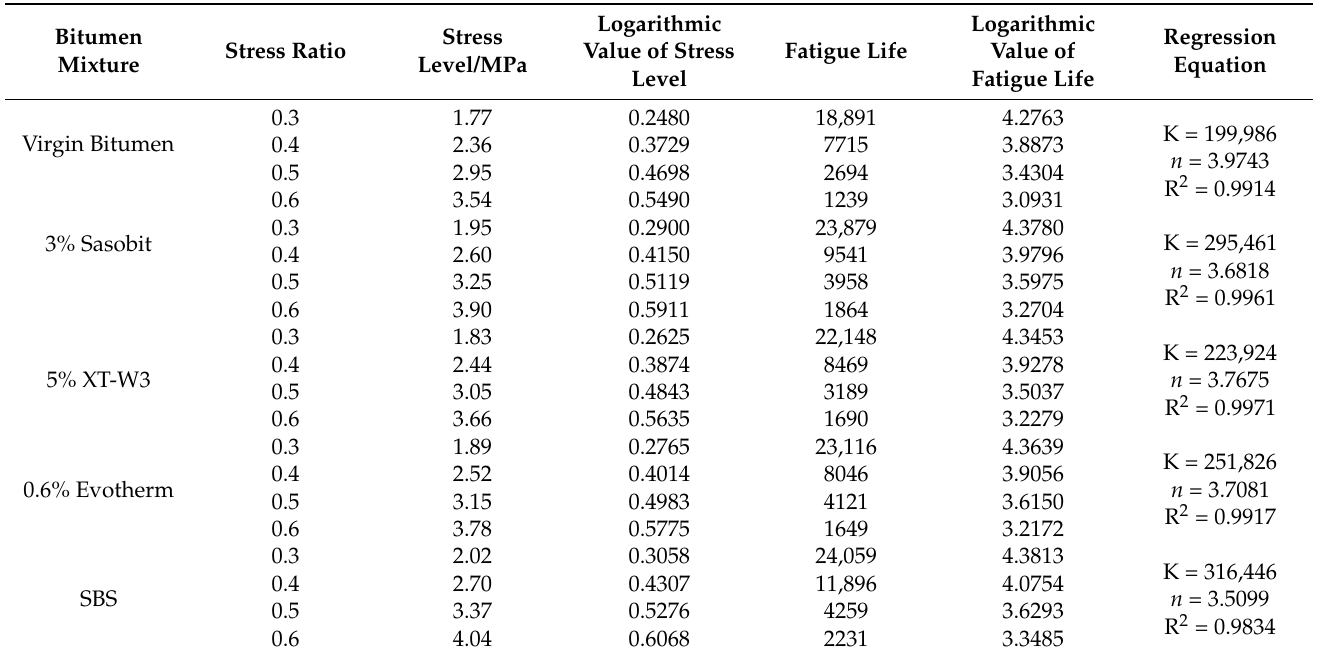
Table 11. Results of the fatigue